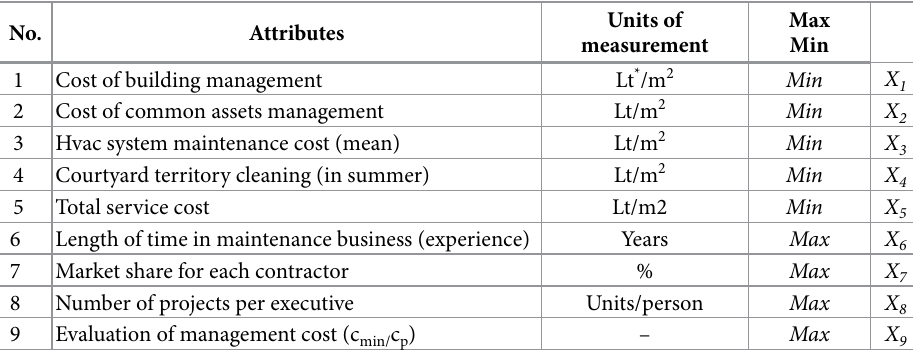
table 1. Main attributes and objectives of contractors in Vilnius (2004) no. attributes